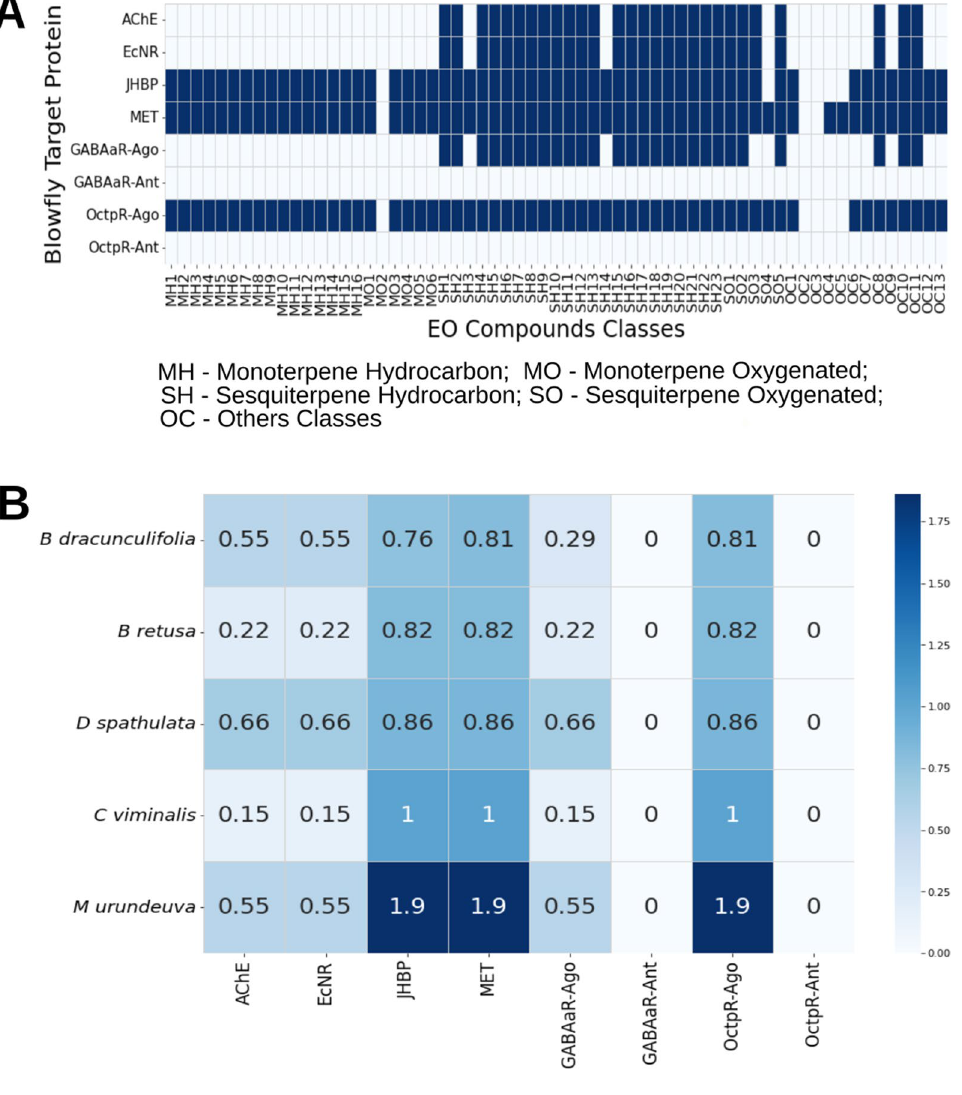
Figure 5. Matrices of the likelihood of plant essential oils compounds affect the blowfly’s protein target low pale-blue and or high deep blue. ID numbers refer to EO compounds in the chemical chromatographic profile of plant species shown in Table S8 and published studies 35,36